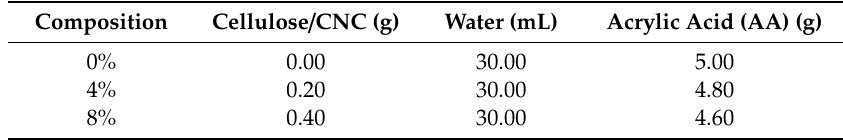
Table 1. Compositions of hydrogels.